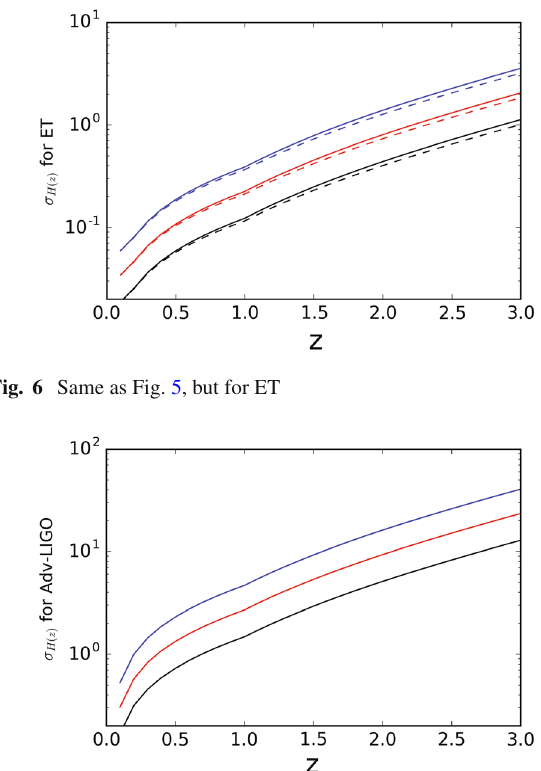
the expression of relative error of d L ( z ) :